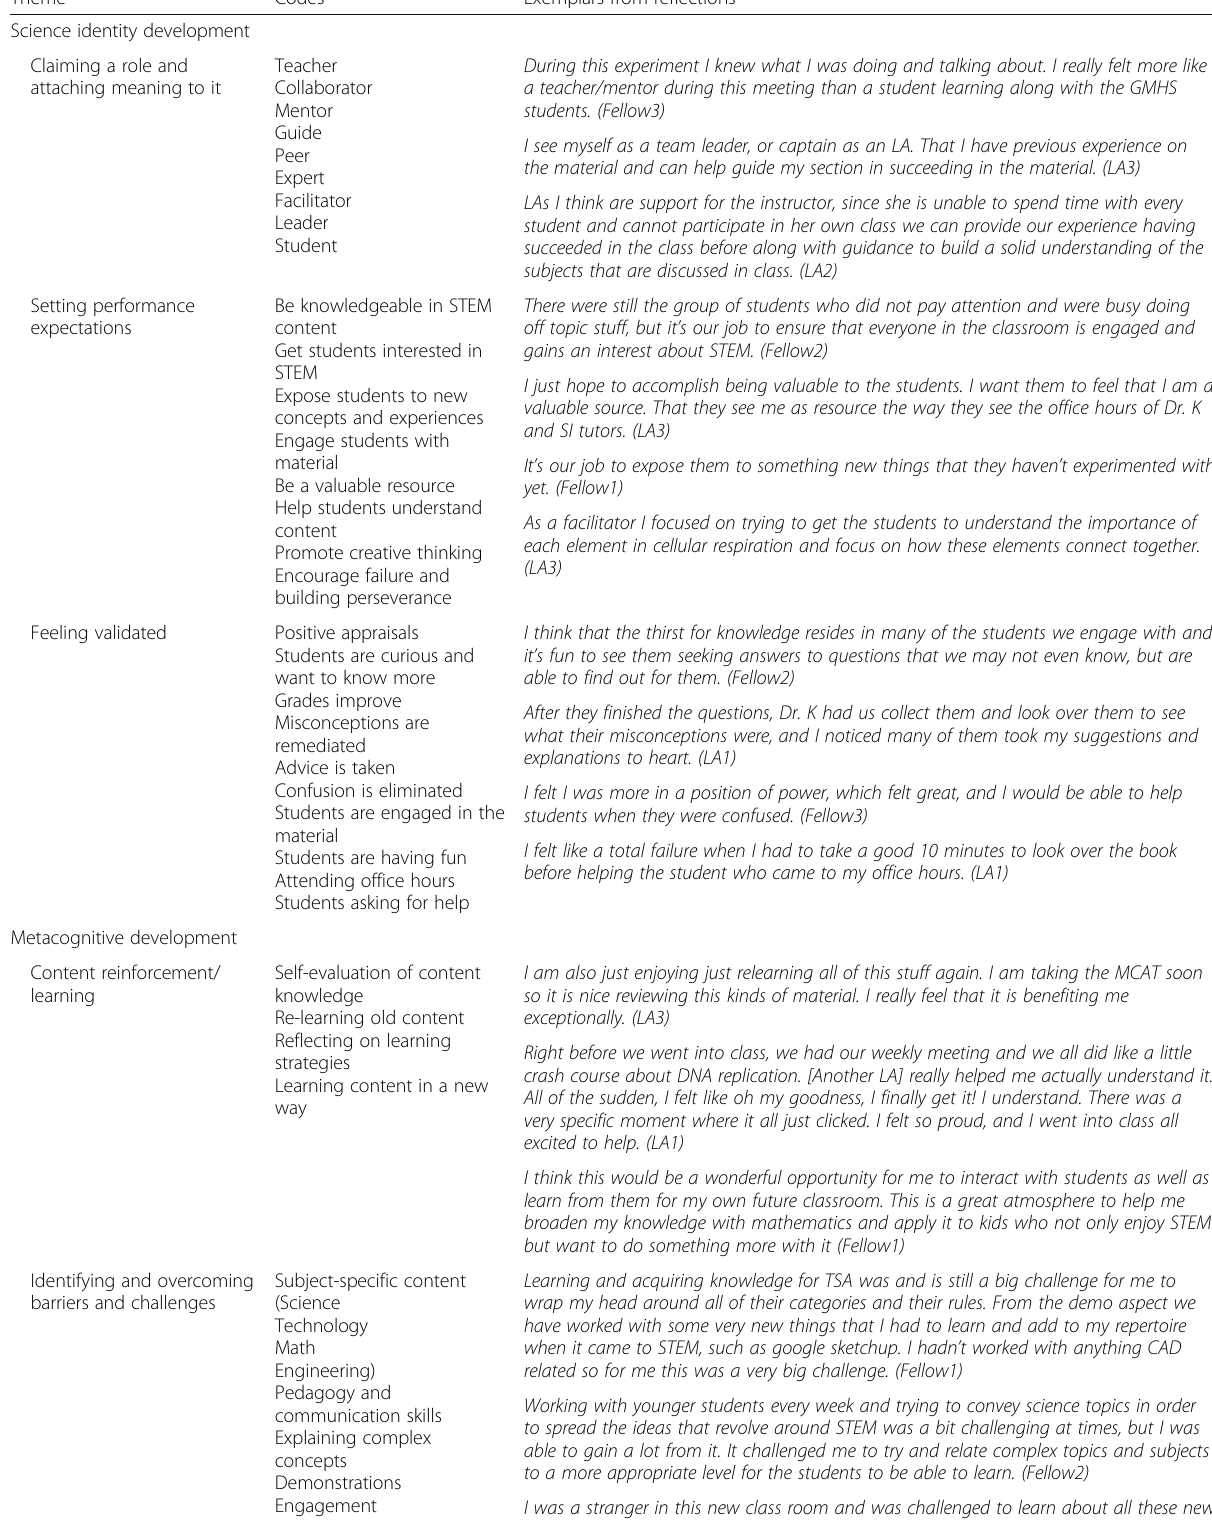
Table 4 Themes, codes, and